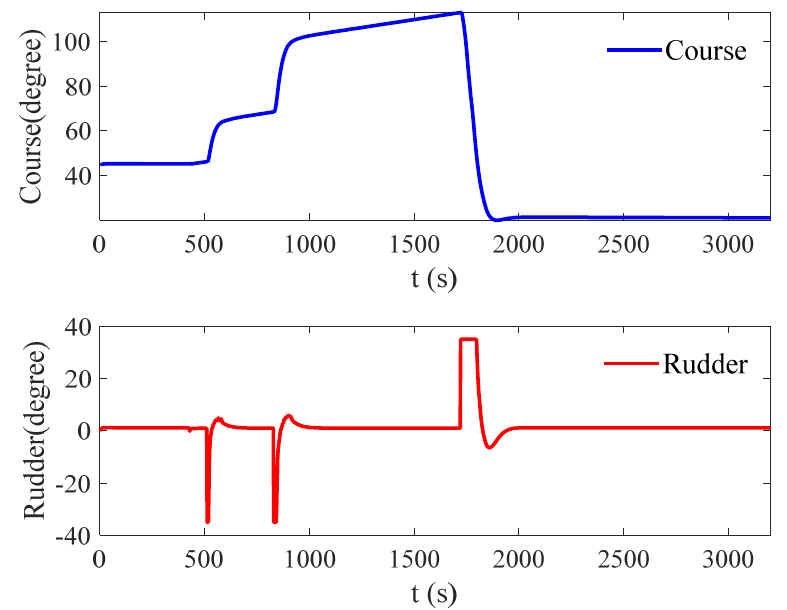
Figure 22. The distance between ship–1 and other ships in scenario 3.